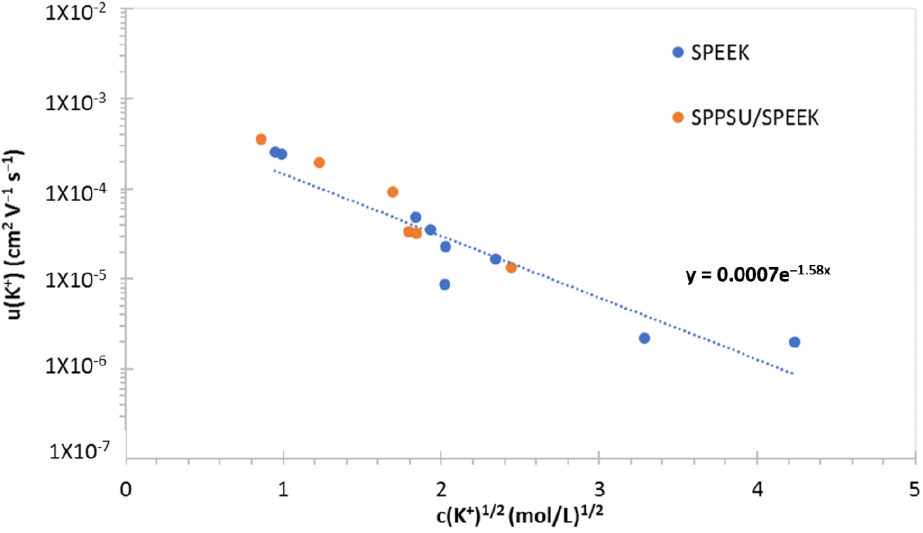
Figure 7. K + ion mobility in various proton exchange membranes based on SPEEK and SPPSU/SPEEK blends.